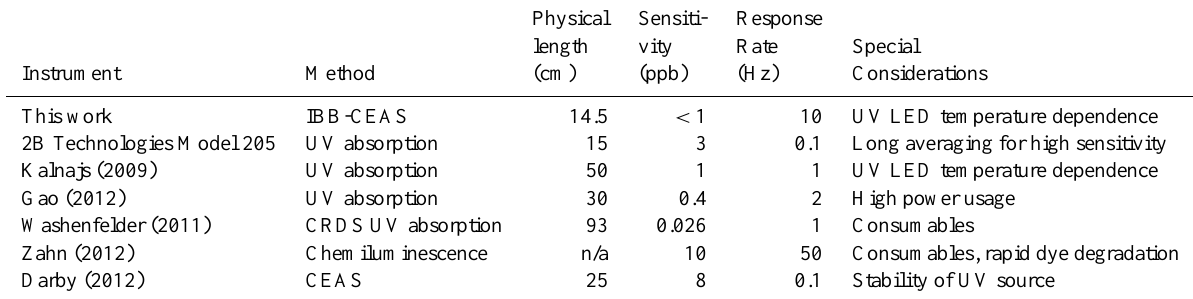
Table 1. Performance comparison of ozone